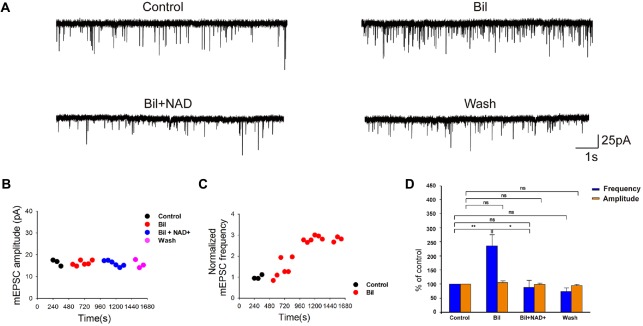
NAD+ inhibited the bilirubin-induced potentiation of mEPSCs. (A) Typical mEPSCs were recorded from each neuron for 3, 6, 6 and 3 min time blocks in control, bilirubin, bilirubin plus NAD+ and wash respectively. (B) Time course of average amplitude of mEPSCs along sample experiments of Panel (A). (C) Representative time course of the effect of bilirubin-induced potentiation of normalized mEPSC frequency in a neuron. Typical time course of mEPSC frequency in a neuron with control period (in black) for 3 min followed by bilirubin application alone (in red) for 21 min is shown. (D) Mean values of normalized mEPSC frequencies and amplitudes before, during and after drug administration. Error bars represent the standard error; *P < 0.05; **P < 0.01; ns: not significant, one-way ANOVA with Student-Newman-Keuls post hoc test.